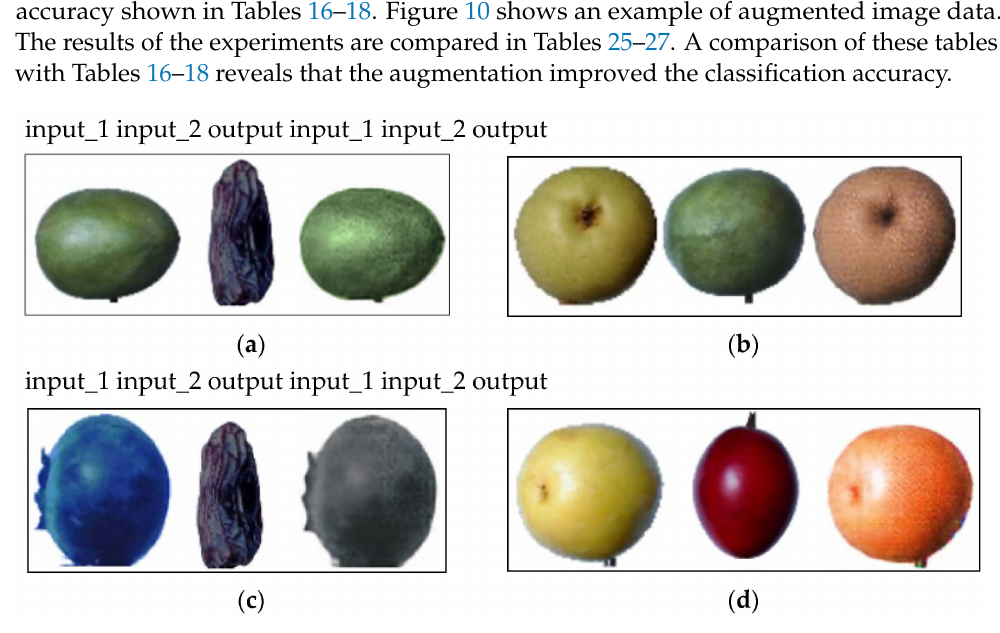
Figure 10. Examples of images augmented by PI-GAN. Left to right: ( a ) mango, date, and aug- mented image; ( b ) pear, mango, and augmented image; ( c ) huckleberry, date, and augmented image; ( d ) maracuja, tamarillo, and augmented